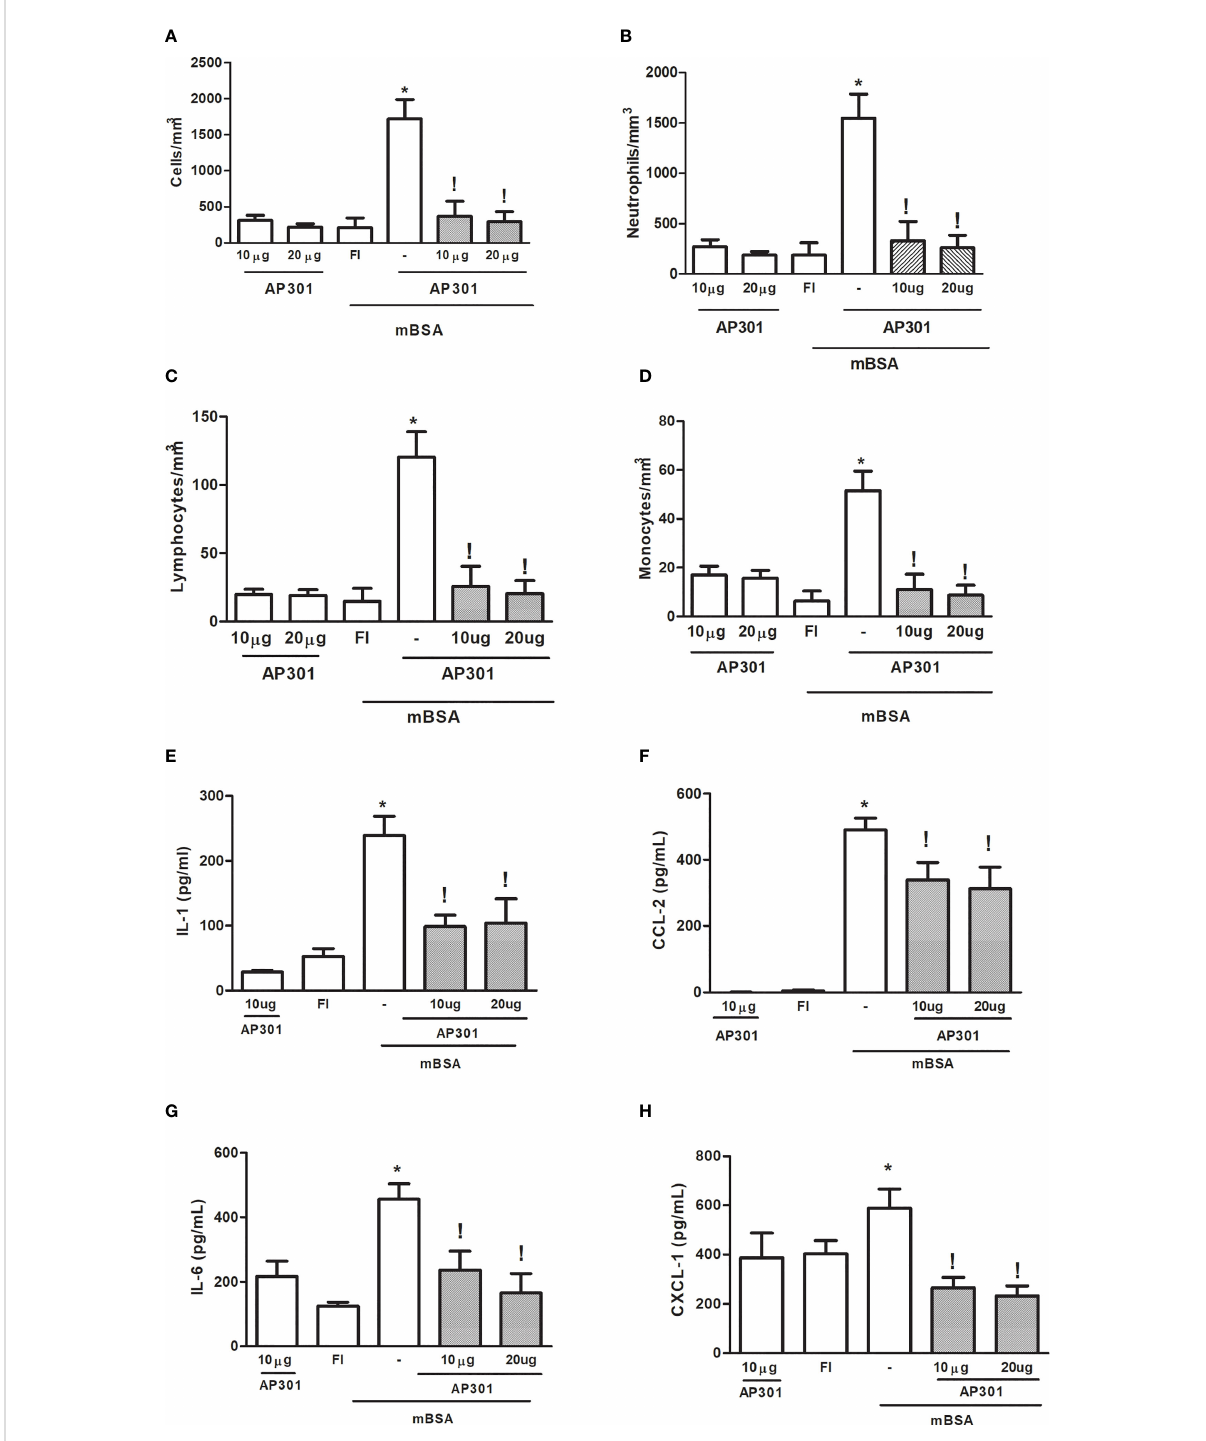
FIGURE 2 Mice subjected to mBSA arthritis received. i.art. solnatide (AP 301) or saline ( − ) 30 min prior to challenge with mBSA. Cell counts and cytokine and chemokine levels were assayed in joint washes collected after 7 h. FI stands for control, false-immunized animals; *p<0.05 compared to FI;! p<0.05 compared to mBSA, using Student ’ s “ t ” test (n ≥ 3 animals/group). (A – D) Total and differential cell counts; (E – H) interleukin (IL-1), IL-6, CXCL-1, and CCL-2